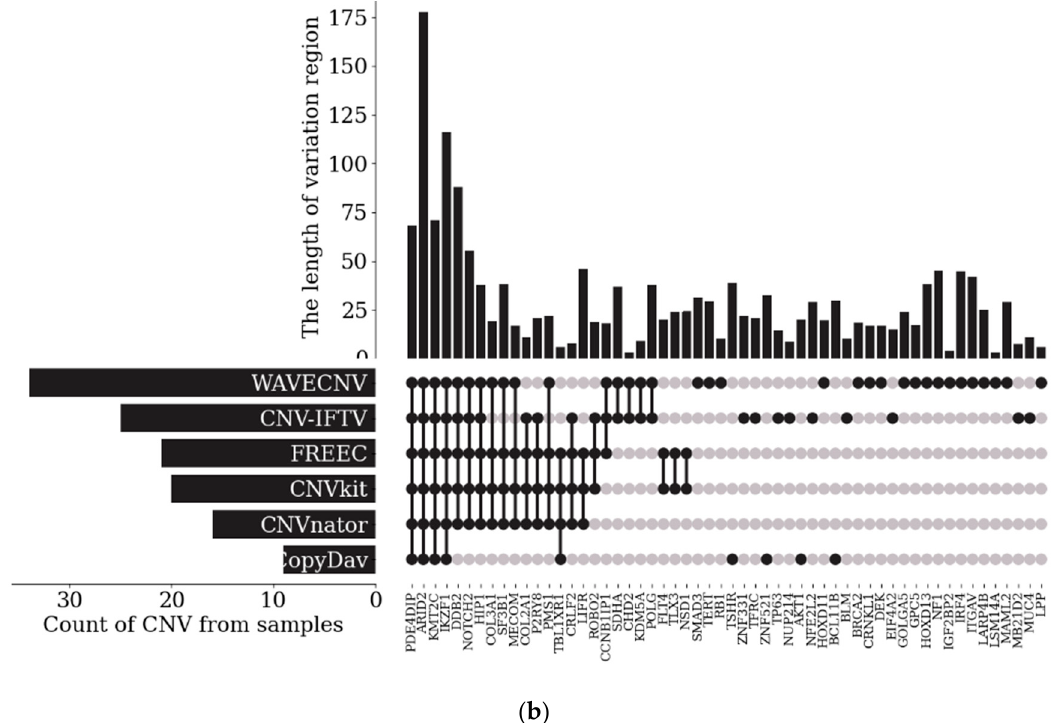
Figure 6. ( a ) The black curve represents the length distribution of cancer genes published by CGC. The red curve represents the length distribution coinciding with the cancer gene fragment in the WAVECNV test results. The curves of other colors represent the length distribution of the detection results of the remaining five methods coinciding with the cancer gene fragment. ( b ) The histogram at the top of the figure represents the length of cancer genes, and the bar chart at the left of the figure represents the number of cancer genes in the results of the six methods. The dot graph at the bottom right of the figure represents the cancer gene fragments detected by the six methods. Black dots represent the fragments that can be detected by this method, and gray dots represent the fragments that are not detected by this